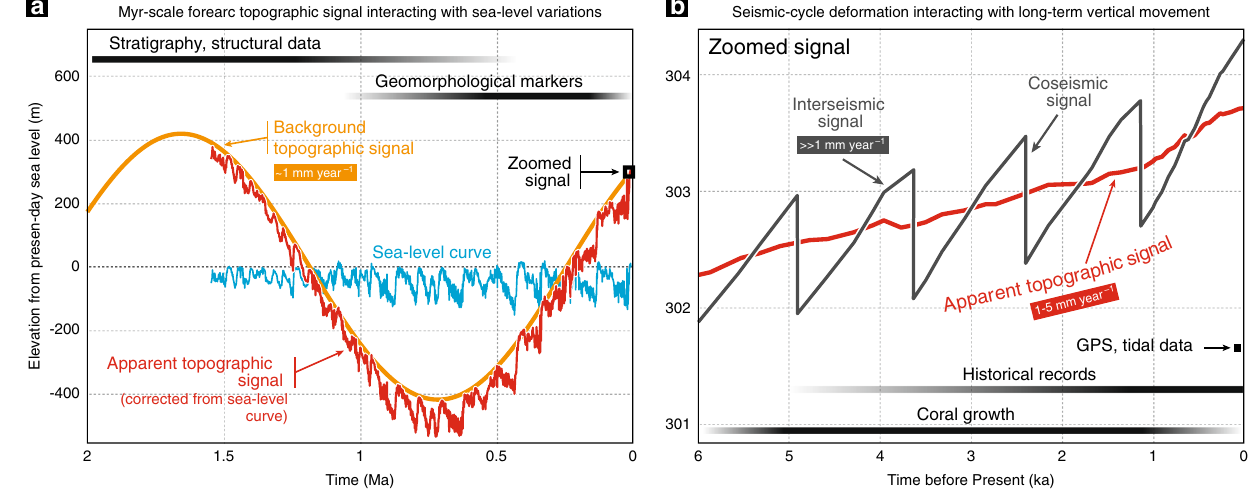
Fig. 5 Interferences between various timescales, forearc topographic signals. a , b Schematic charts evidencing long-term ( a ) and short-term ( b ) vertical signals potentially recorded along active forearc margins. The three periodic topographic signals at Myr (orange), kyr (red) and 10 2 -year scale (dark grey) are related to tectonic underplating (this work), glacio-eustatic sea level variations and earthquake cycle, respectively. The apparent topographic signal (red) is obtained by subtracting the sea level curve 81 (blue) to the background topographic signal (orange). Usual methods for investigating vertical surface displacements are indicated on these two charts as a function of their speci fi c observation time window. Note that underplating-controlled topographic signal can apparently be tracked only by long-term markers, such as stratigraphic and structural records. It is also noteworthy, from these charts, that fast vertical displacement vectors recorded at year and kyr scale can be opposed to the slower Myr-scale signal. Tectonic underplating and associated long- term uplift can thus occur along subduction segments where a kyr-long subsidence event is recorded and vice